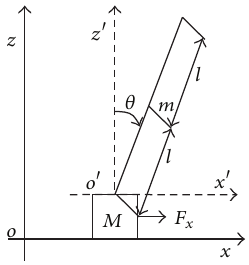
Figure 1: Structure of inverted pendulum.